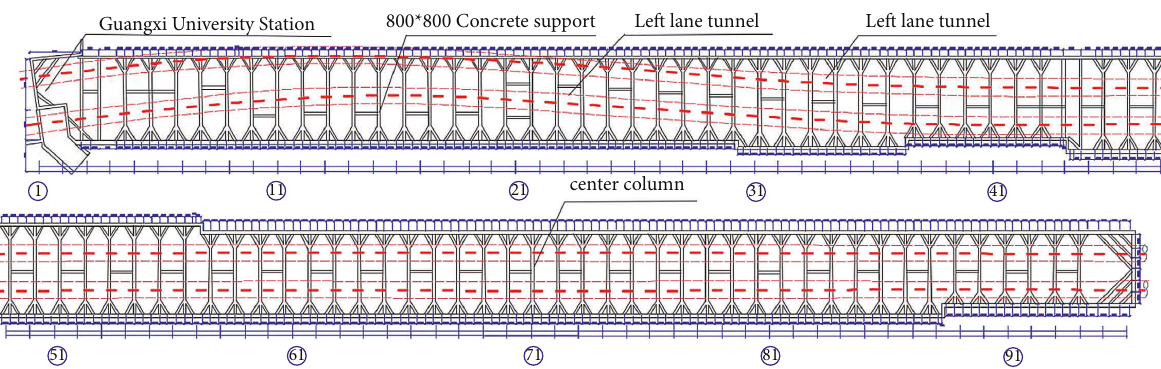
Figure 2: Supporting structure of deep foundation pit adjacent to existing tunnel Guangxi University of Finance and Economics.